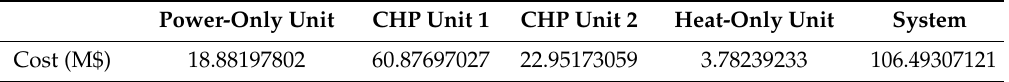
Table 5. Total cost of the long-term plan.